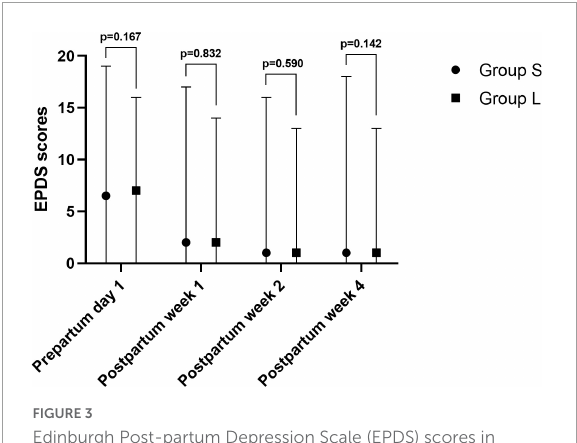
FIGURE3 Edinburgh Post-partum Depression Scale (EPDS) scores in patients.